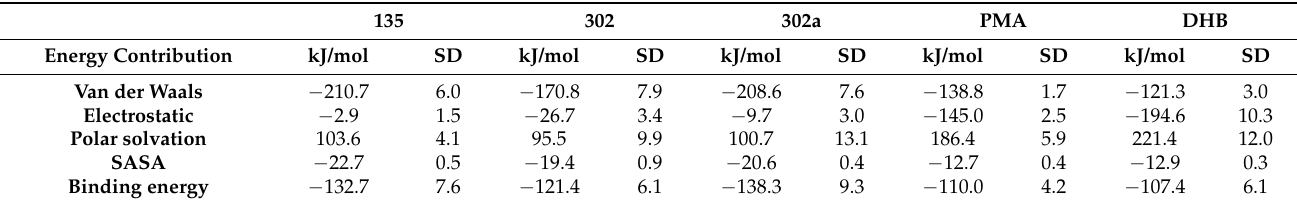
Table 6. Binding free energies (kJ/mol) from the MM/PBSA calculations for three of the best-ranked structures identified for Lb PTR1; DHB and PMA were used as reference ligands.